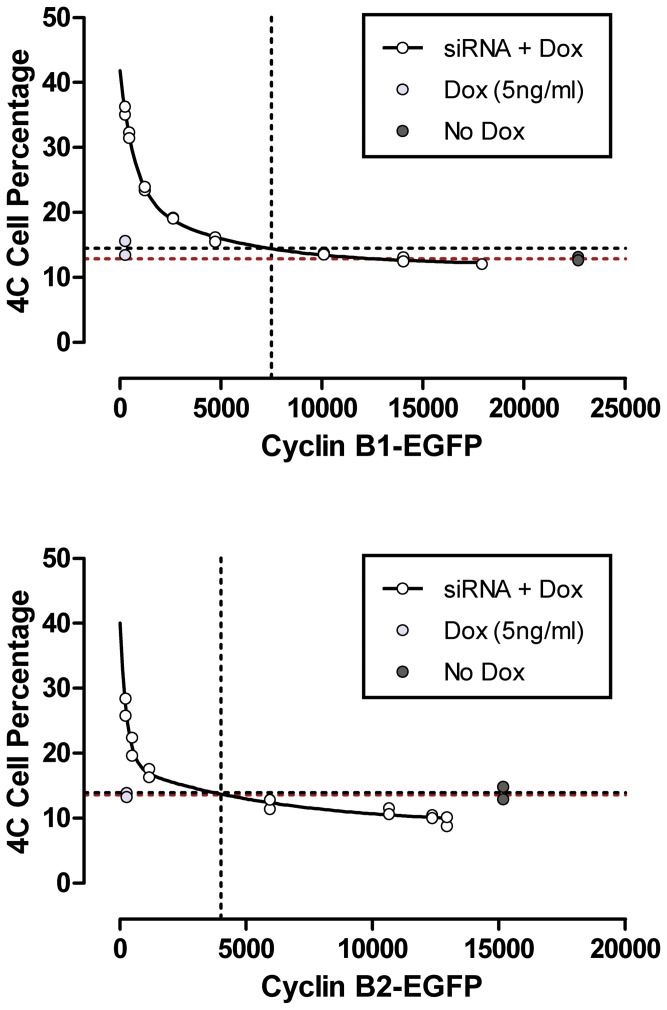
Single B cyclin EGFP completely rescues the G2 arrest of cyclin co-depletion as a function of dose.p015-4 and p017-4 cells were transfected with B cyclin siRNA in the presence of Dox at stepped levels for 24–30 h. EGFP fluorescence and the fraction of 4C cells were measured by flow cytometry (siRNA + Dox). Controls were transfected with scrambled siRNA and expressed endogenous and exogenous B cyclins (No Dox) or only endogenous cyclins (Dox).